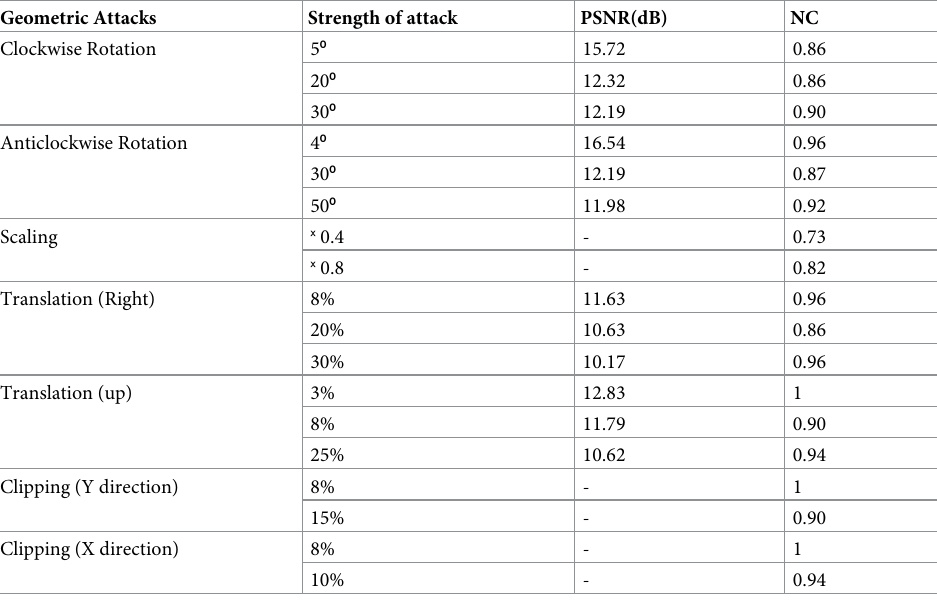
We applied clipping attacks with 8% and 10% strengths on both the x-axis and y-axis. The cor- relation value results are 100% nearly in both axes. The results after attacks are illustrated in Table 3. Geometric attacks based on NC and PSNR values using the DCT-SURF. Geometric Attacks Strength of